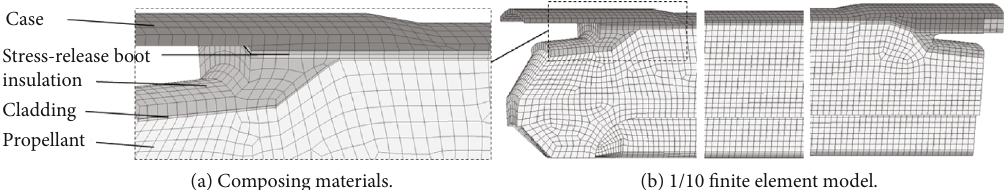
Figure 7: Composing materials and 3D fi nite element model of SRM grain.